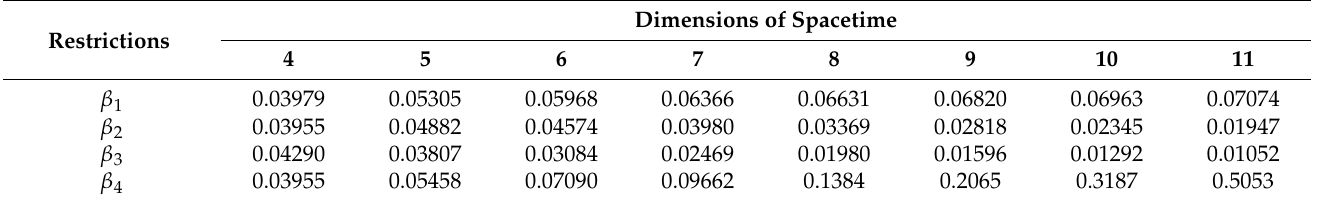
Table 1. The restrictions on the reduced charge-to-mass ratio squared, β ≡ α 2 / k n , in various dimensions.